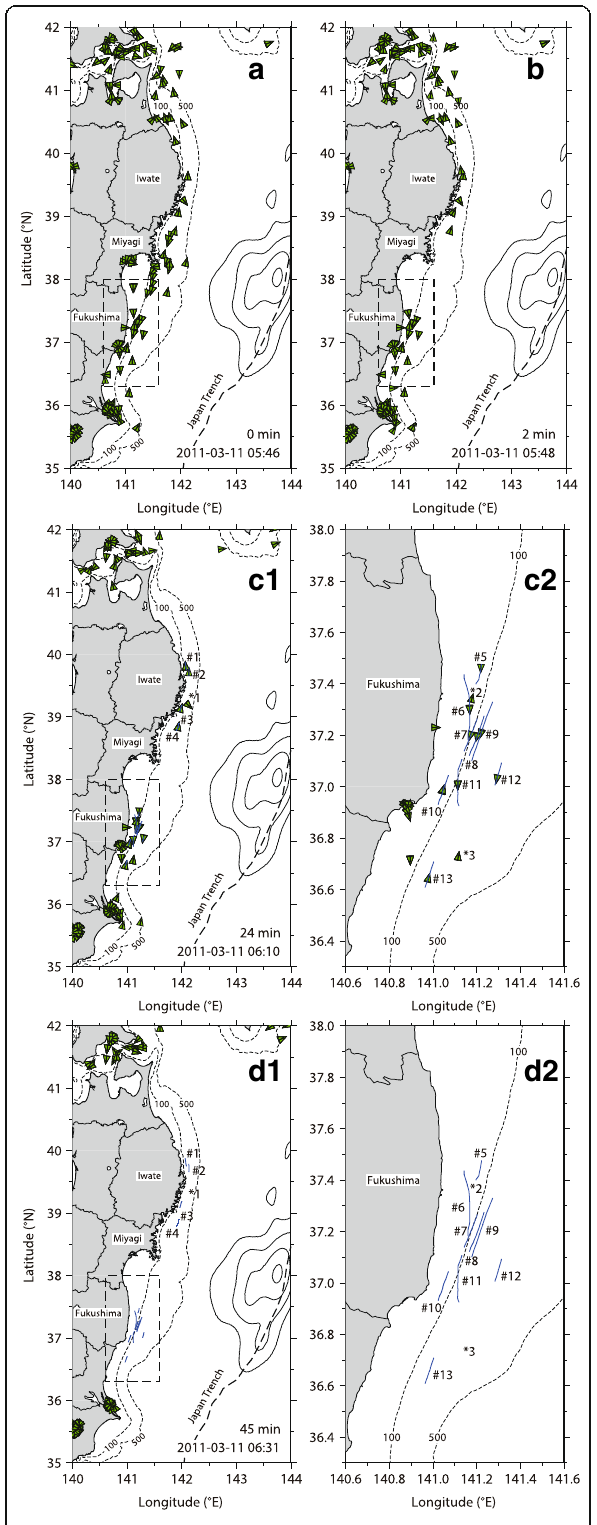
Fig. 2 Ship distributions derived from AIS data during the 2011 Tohoku tsunami. Distributions at a 0 min, b 2 min, c 24 min, and d 45 min after the earthquake occurrence are shown. In c and d , the right panel enlarges the rectangular area in the left panel, and blue lines trace ship tracks of 13 offshore vessels during 0 – 45 min after the earthquake occurrence (Table 1). Dashed isobaths of 100 and 500 m are